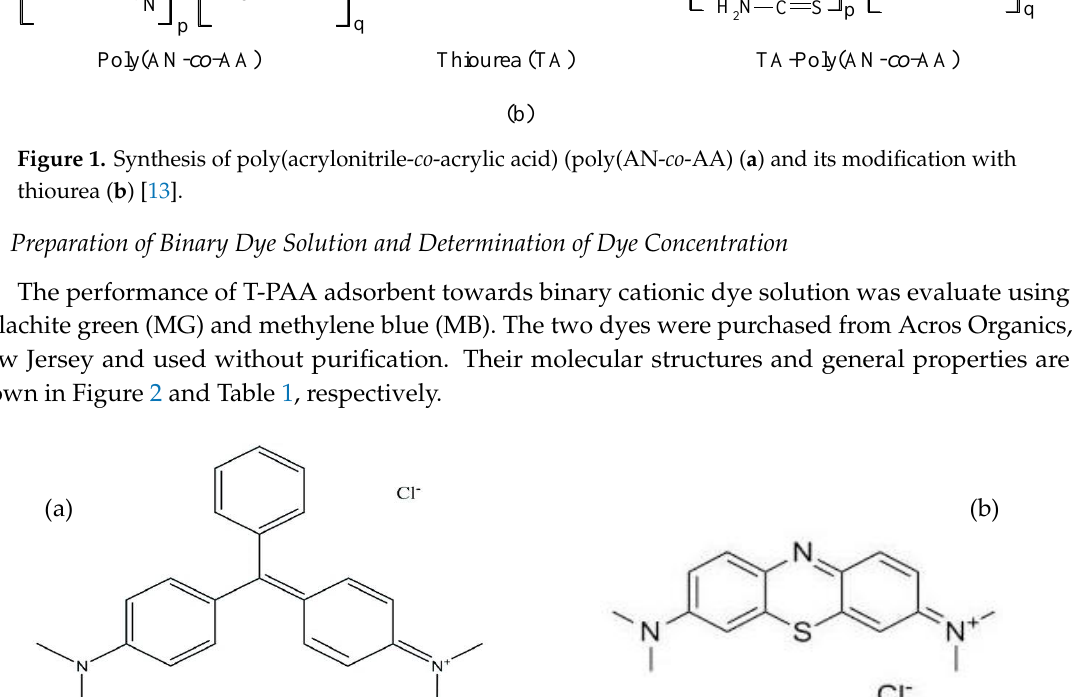
Figure 1. Synthesis of poly(acrylonitrile- co -acrylic acid) (poly(AN- co -AA) ( a ) and its modification with thiourea ( b ) [13].